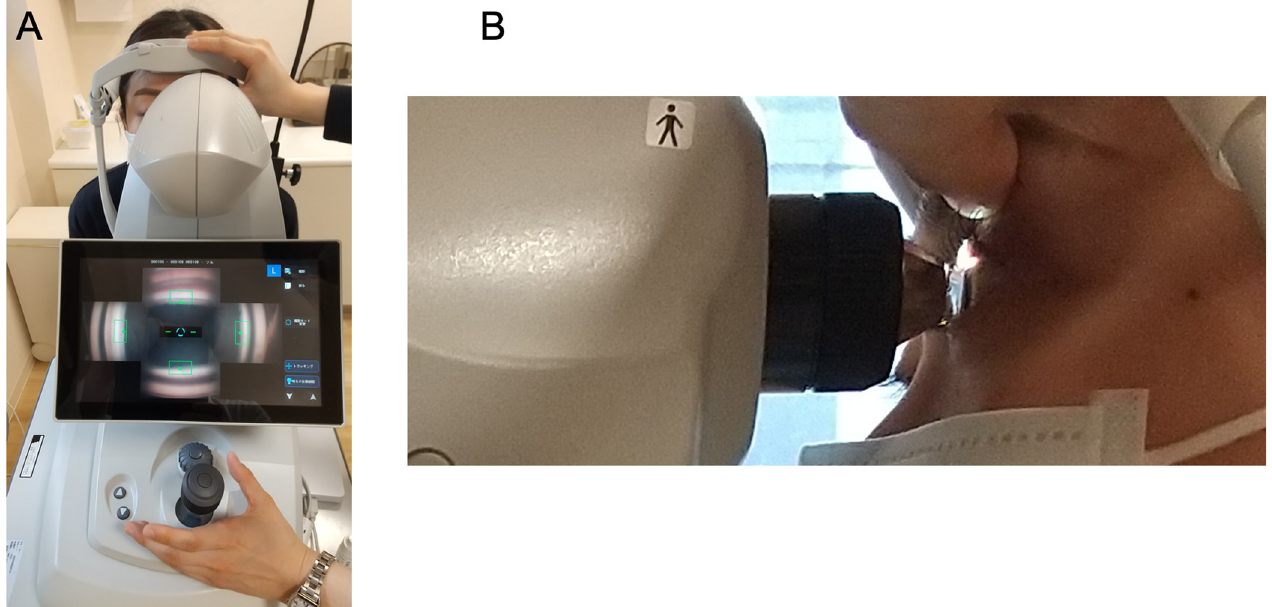
Fig 1. The images during a GS-1 examination. Panel A shows the monitor of GS-1 during the examination. The screen displays angle images in four directions in real-time, allowing the examiner to check whether the image is in focus. Panel B shows the GS-1 examination from the side. Lenses are large and require a wide opening of the eyelids.